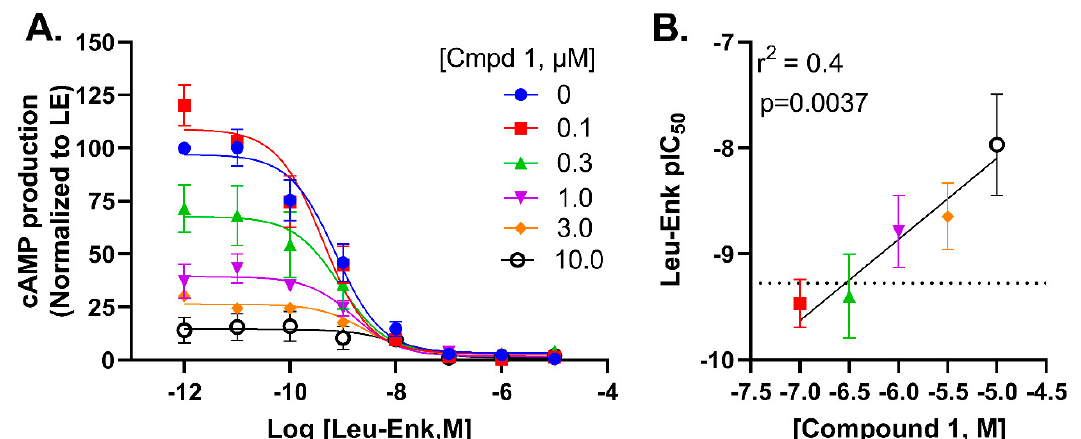
Figure 7. Compound 1 acts as a negative allosteric modulator for leu-enkephalin potency in the cAMP glosensor assay. ( A ) . Dose-dependent inhibition of forskolin-mediated cAMP production by Leu-enkephalin (Leu-Enk) in the absence or presence of increasing concentrations of compound 1 . ( B ) . The decrease in Leu-enkephalin pIC50 is correlated with increasing concentration of compound 1 .